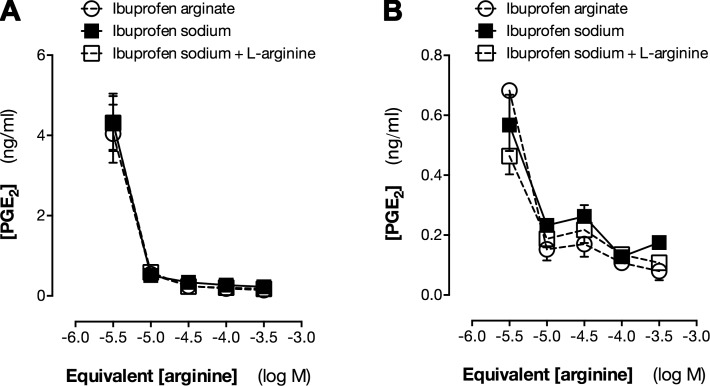
Ibuprofen arginate inhibits COX-2 in mouse (A) and human (B) cells. PGE2 release from mouse RAW264.7 cells stimulated with LPS (1 µg/ml) (A) and human A549 cells stimulated with IL-1β (10 ng/ml) (B) to induce COX-2. Data are presented as means ± sem for n = 4. P > 0.05 by 2-way ANOVA for all comparisons.